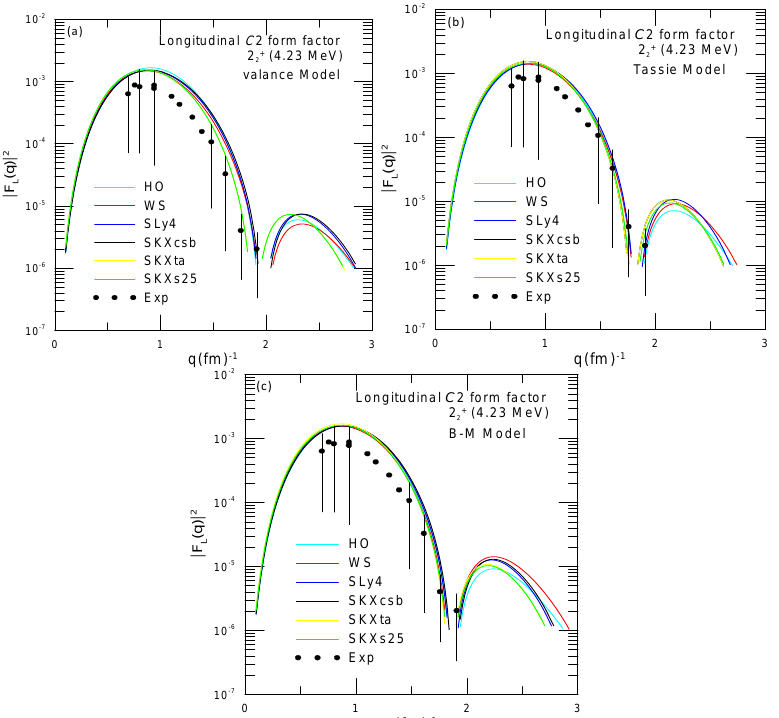
Fig.4: Theoretical longitudinal form factors for the second 2 2+ , 4.23 MeV state using different single particle potential compared with the experimental data taken from Ref.